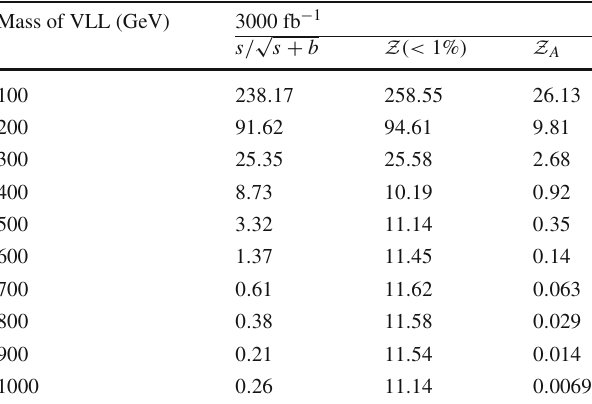
Table 6 Signal significance for VLL single-production at the LHC calculated with the neural network trained in the 700 GeV data, with the network details shown in Table 9 Mass of VLL